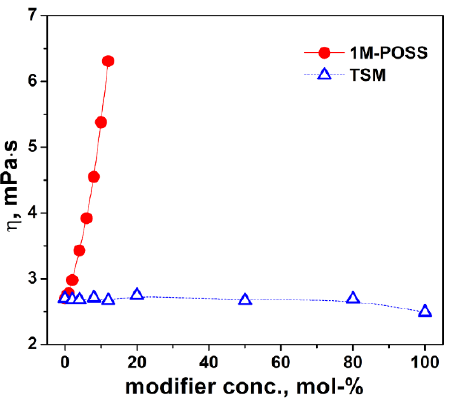
Figure 2. Viscosity of LM/1M-POSS and LM/TSM systems at 40 °C as a function of the Si-containing modifier concentration. The lines are eye guides.